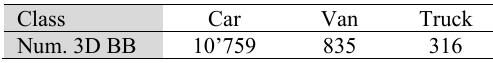
Table 2 . Classes and the number of contained 3D bounding boxes (3D BB) in KITTI 3D object detection dataset (Geiger et al., 2012) after filtering.